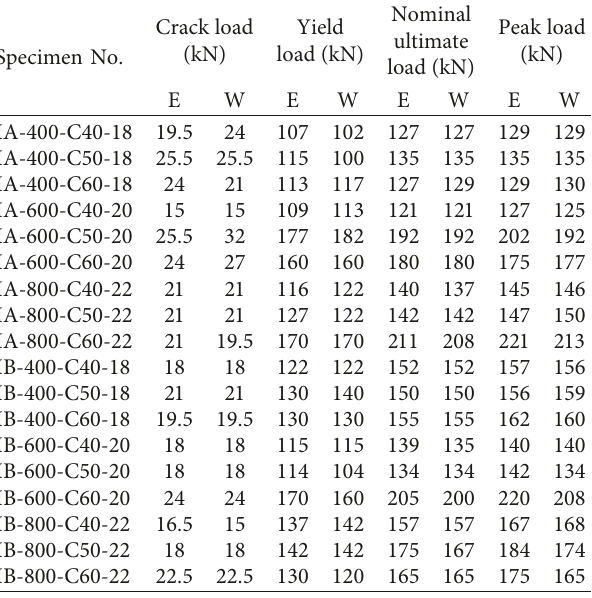
Table 4: Load of the interior beam-column connection at char- acteristic points. Specimen No.